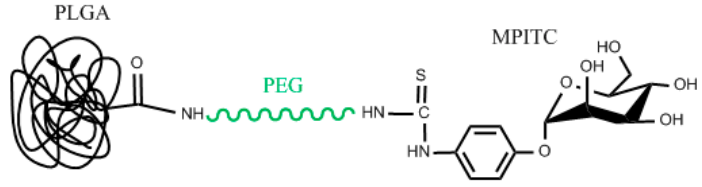
Figure 4. Chemical connectivity of PLGA-PEG-Mannose nanoparticle design.